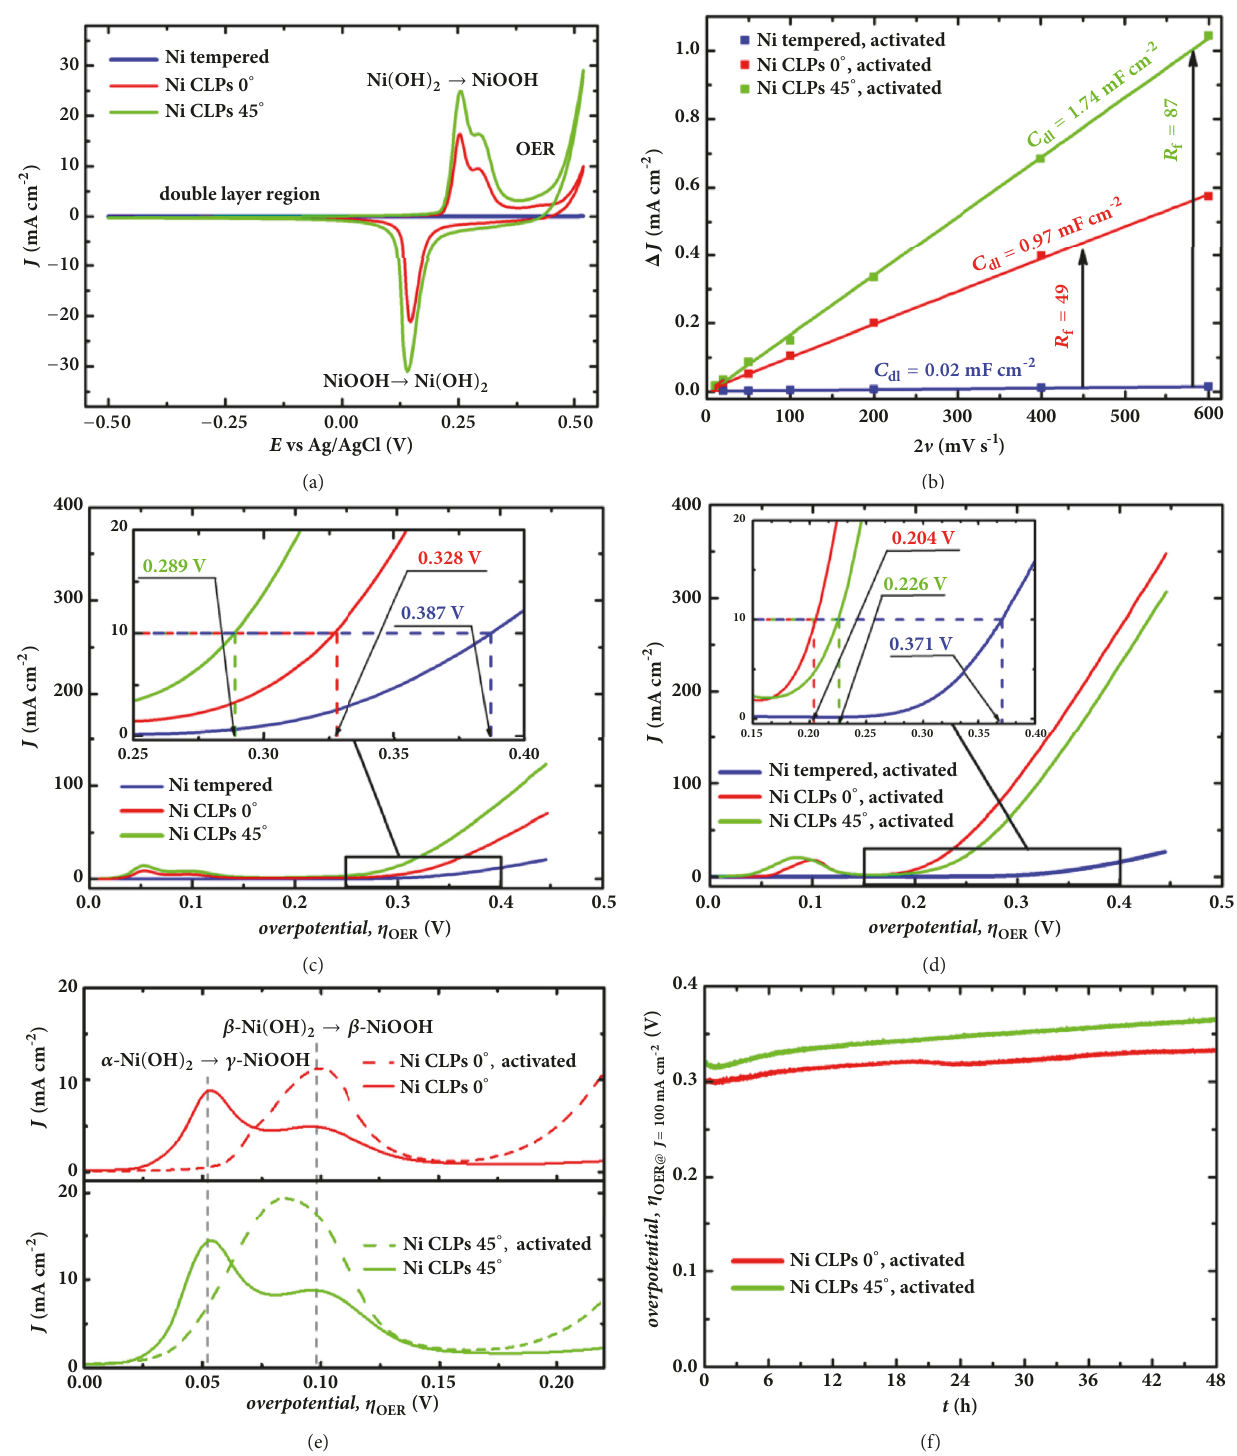
Figure 3: Cyclic voltammograms (CV) of as prepared laser-structured and tempered Ni plates ( a ) with a scan speed of ] = 20 mVs −1 . All electrochemicalmeasurementswere performed in 25wt.-% KOH solution at room temperature.The sum of the absolute anodic and cathodic current densities versus the scan speed ] ( b ). The slope of the resulting fit curves corresponds to the double layer capacitances of tempered and laser-structured Ni electrodes. The corresponding CV cascades can be found in the supplementary information. CVs were carried out at nonfaradaic regions in a potential window of Δ E = 0.1 V around the open circuit potential. Linear sweep voltammograms as prepared ( c ) and activated ( d ) recorded with a scan speed of ] = 10mVs −1 . Inset: magnifications of the area at J = 10 mA cm −2 with markings highlighting the corresponding overpotentials at J = 10mA cm −2 . Magnified linear sweep voltammograms in the potential region of the Ni(OH) 2 to NiOOH oxidation ( e ).Chronopotentiometriccurvesfor long-termstability of thewaterelectrolysis electrodesata currentdensity of 𝐽 = 100 mAcm −2 ( f